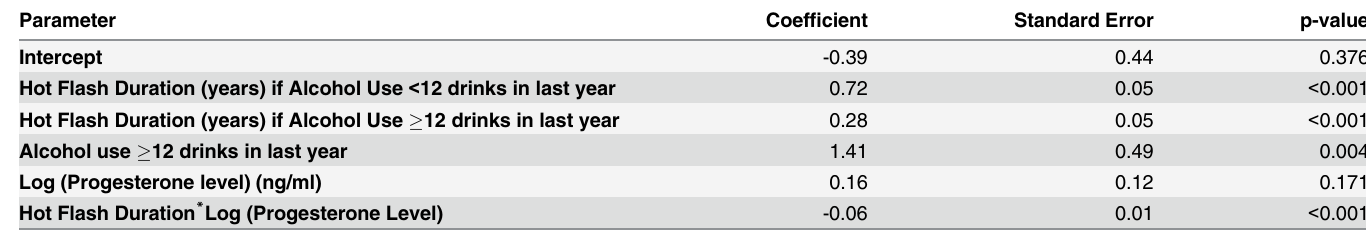
Table 3. Final model * for years to peak hot flash severity in US